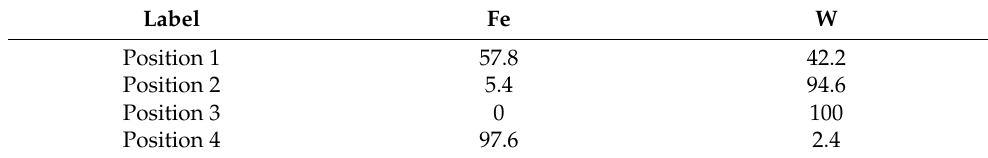
Figure 7. SEM image of the cross section at the interface of W w and steel after 2000 cycles with 5 MW/m 2 . The numbers indicate the locations of the EDX measurement spots. Table 2. Local composition (labeled in Figure 7) determined by EDX in